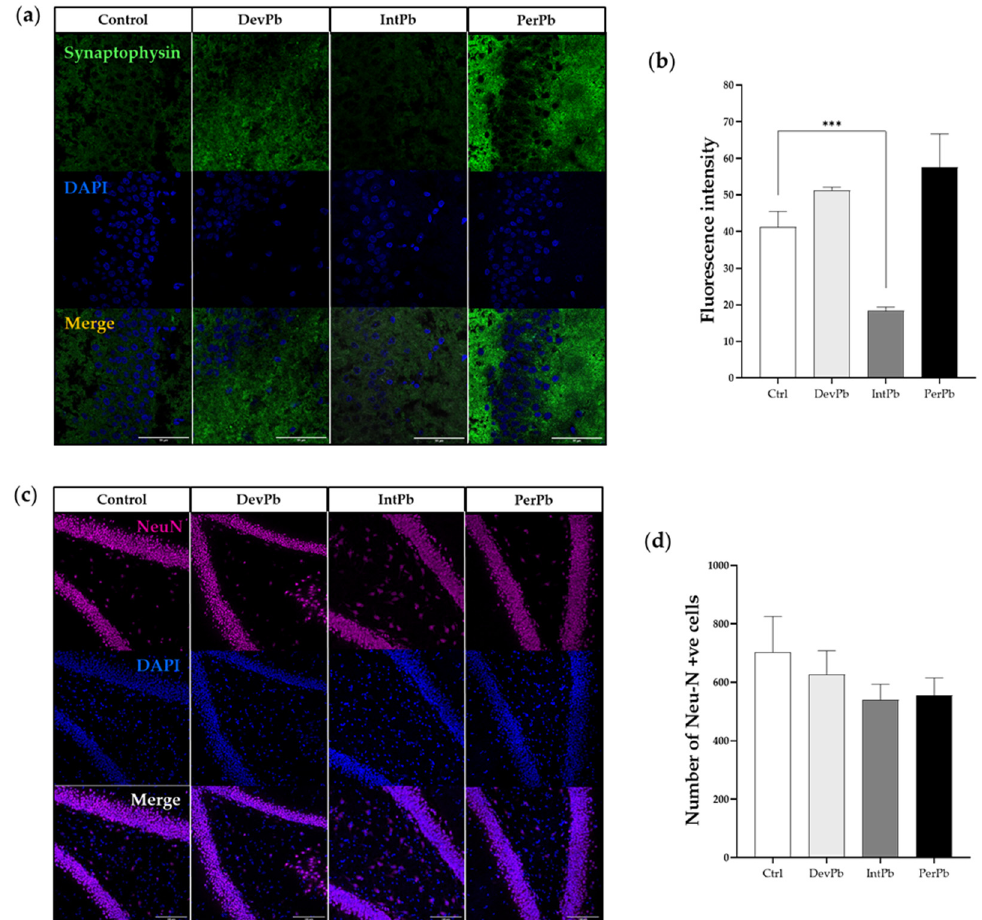
Figure 4. Synaptic alterations (Syn) and neurodegeneration (NeuN) results from the immunohisto- chemistry technique: ( a ) Representative images of the Syn (1:500)-stained pre-synapses. ( b ) Histogram of the fluorescence intensity of the Syn staining. ( c ) Representative images of the NeuN (1:500)-stained neurons. ( d ) Histogram of NeuN-positive cells’ quantification. Images were acquired using a confocal point scanning microscope (Zeiss LSM 880 with Airyscan) with 20× objective. Scale bar is 50 µm for stained images. Values are the mean ± SEM. The asterisks denote statistically significant differences between groups; *** p < 0.001; one-way ANOVA, with multiple comparisons (Dunnett’s test); n = 4/group.